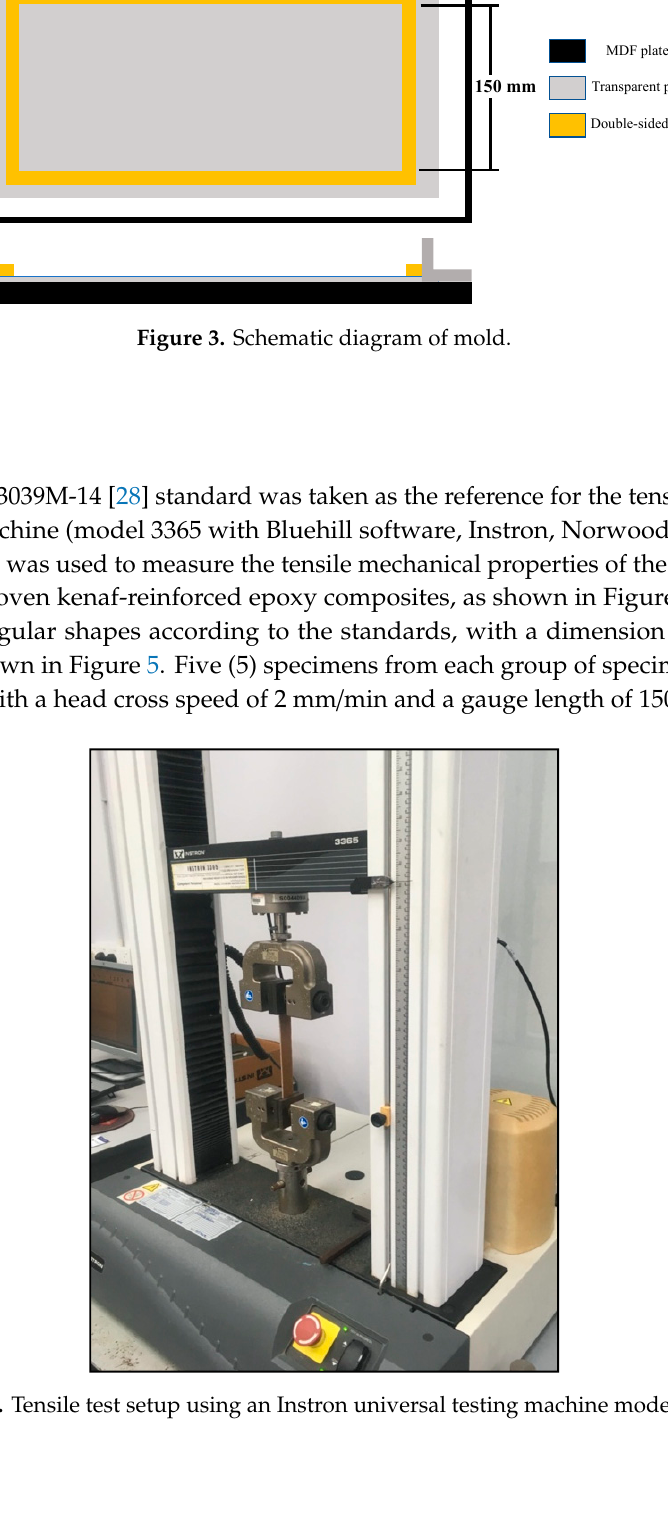
5 of 16 Figure 2. Unstitched and silk-fiber-stitched woven kenaf: ( a ) UNSTITCHED; ( b ) WKS/X; ( c ) WKS/XY. 2.2. Preparation of Composite Laminates A hand lay-up method was used to fabricate the unstitched and stitched woven kenaf-reinforced epoxy composites. The dimensions of the mold that was used in this study are 300 mm in length and 150 mm in width. Double-sided tape was used to draw the dimension of the mold and a plastic film was used to prevent the sticking of the epoxy with the medium-density fiberboard (MDF) flat surface that was used for the fabrication, as shown in Figure 3. Three layers of woven kenaf with 300 mm length and 150 mm width were used for the fabrication process. The woven kenaf had the same number of warp yarns and weft yarns per unit area. Before fabrication, all the woven kenaf (unstitched and stitched) pieces were dried at 80° Celsius for 24 h using a ventilated oven. The average value of moister content was (7.3% of the total weight of the specimens). The percentage of the weight decrease was calculated by subtracting specimens’ weight after heating values from specimens’ weight before heating values divided by specimens’ weight before heating values then multiplying this by 100. After this, the average was calculated by adding the obtained results and dividing them by the number of specimens. An epoxy system (EpoxAmite TM 100) with (102 medium) hardener supplied by (SATSUKU Corporation, Tokyo, Japan) was used with a mixing ratio of 100 Å: 24 B by weight according to the manufacturer’s recommendations. In the unstitched case, each layer of the fiber was impregnated in the mold individually, introducing resin between every single layer. However, for the stitched woven kenaf, two layers of resin were poured, one under the stitched